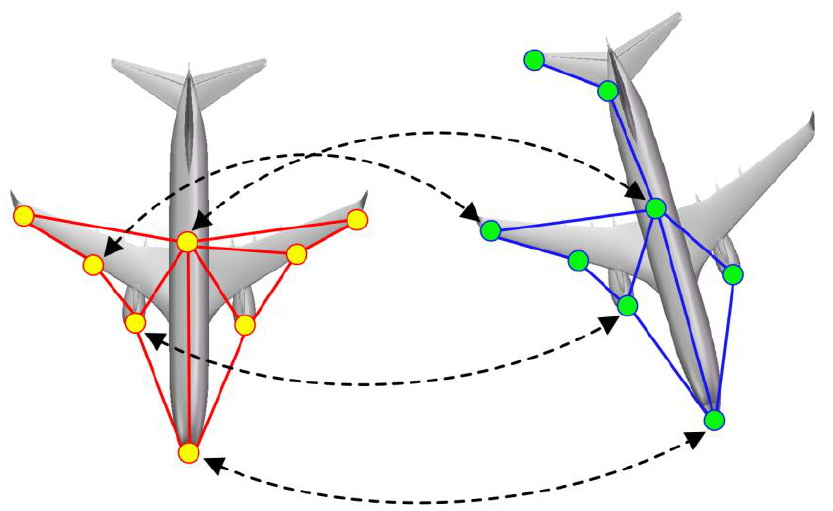
Figure 3. An example of a Graph-Matching problem.